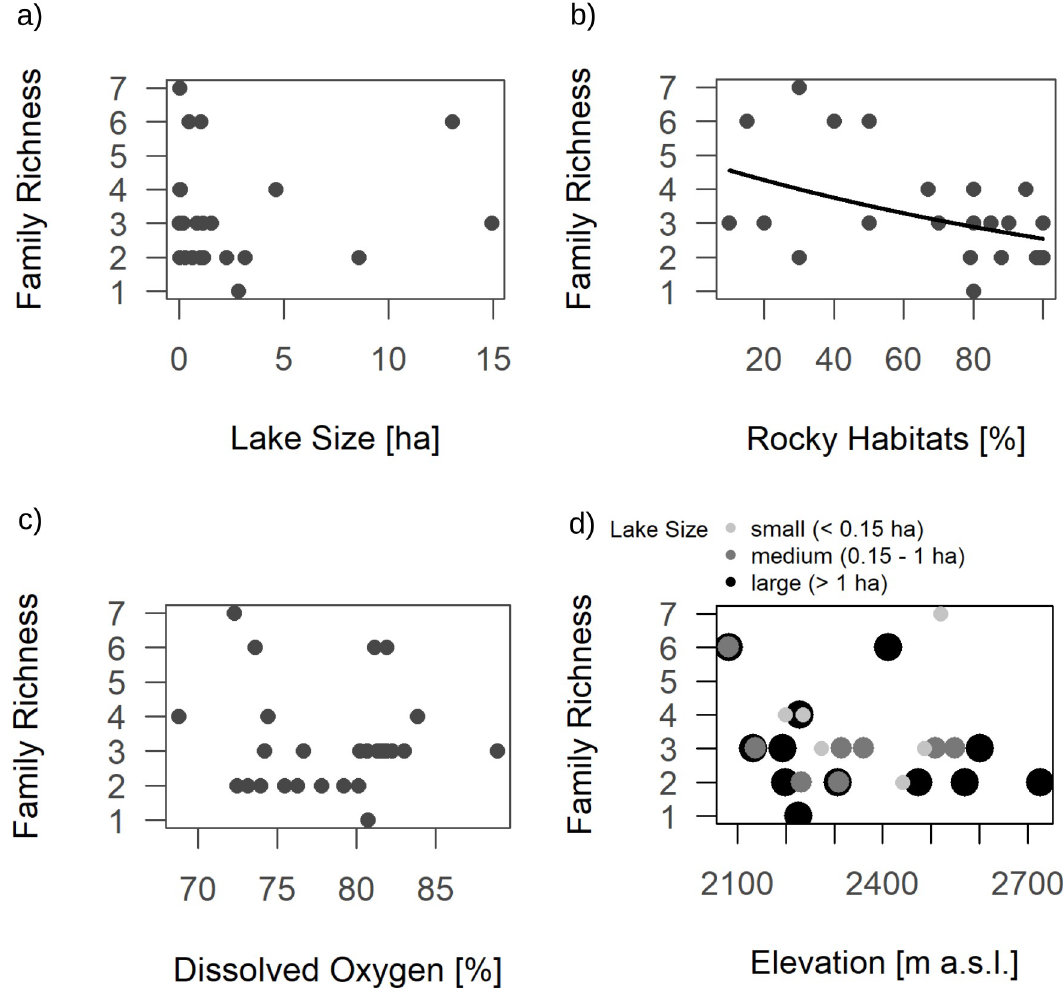
Fig 3. Effect of total family richness in alpine lakes and a) lake size; b) proportion of rocky habitats (sum of small rocks and sheer rock faces/boulders); c) dissolved oxygen and d) the interaction of elevation and lake size, where lake size is visualized by different shades of grey and size of the symbols. Regression lines from generalized linear regression with quasipoisson distributions and log- links are shown for significant effects (Table